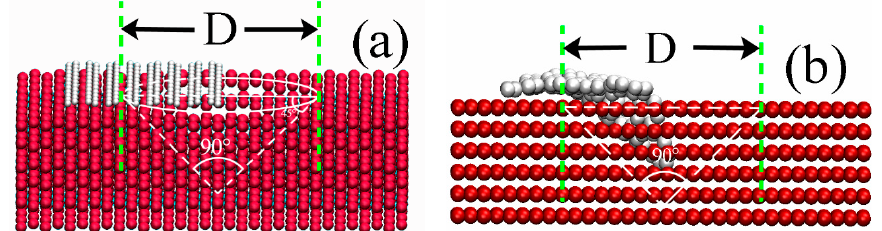
Figure 4. ( a ) Schematic of a piece of flat graphene sheet covering half of a conical pit with an angle of 90°; or ( b ) the sheet bending into the pit.